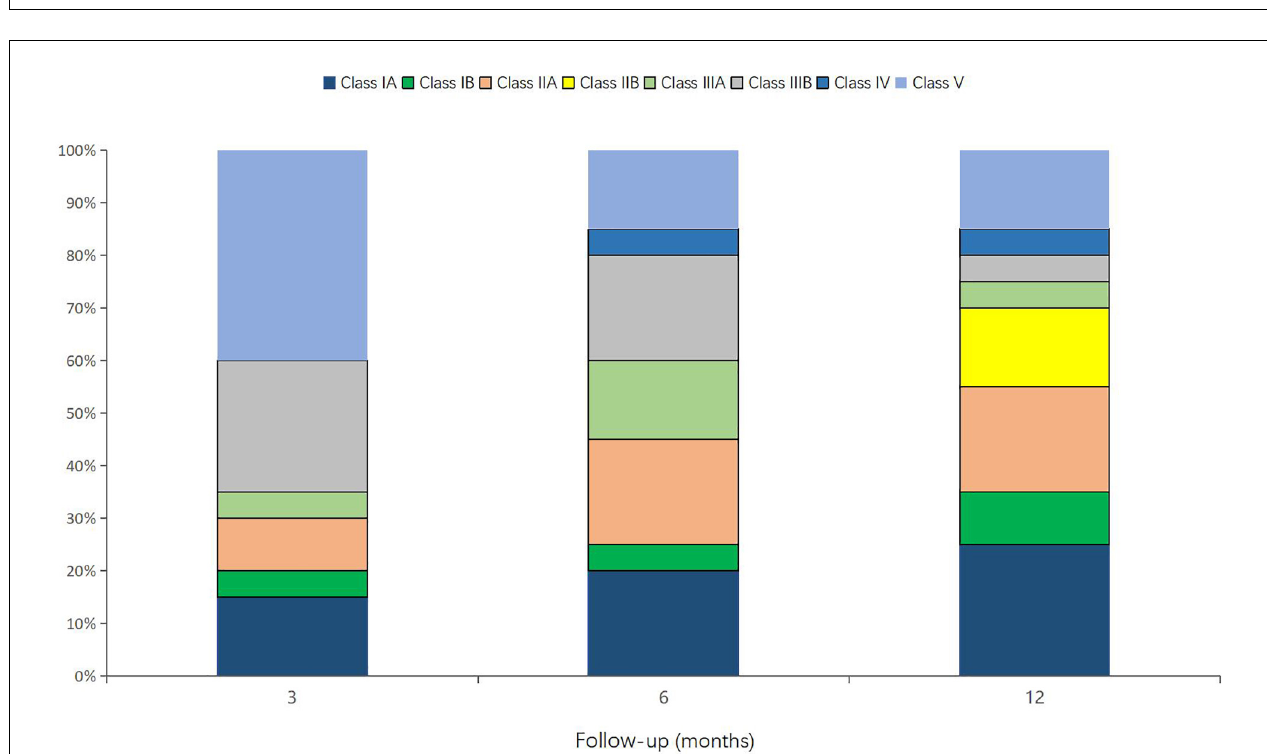
FIGURE 1 | Median seizure reduction, effective rate, and rate of seizure freedom (%).